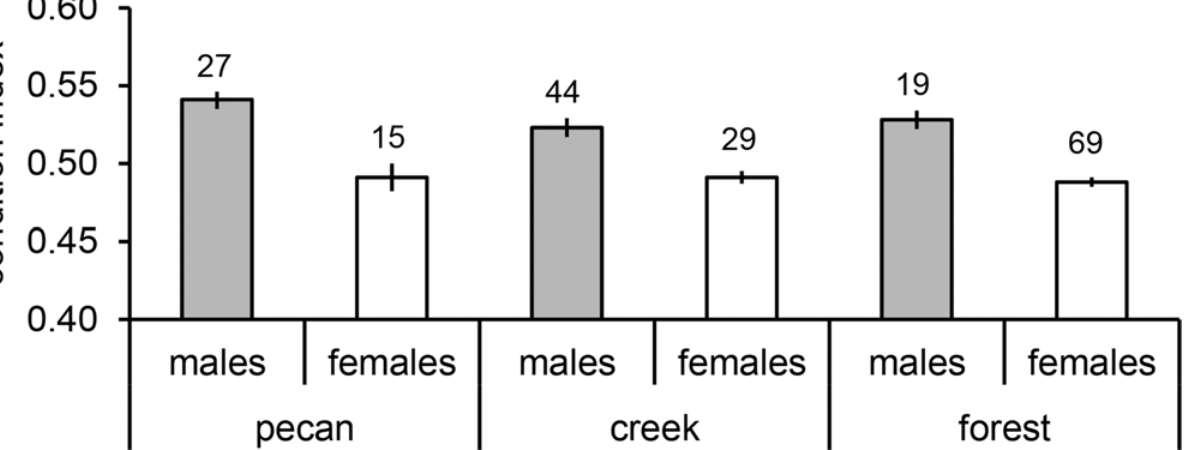
Fig 3. Body condition of males and females. Mean body condition ( ± SE) for males and females in pecan groves, forest fragments along creeks and forest are shown. Body condition represents the quotient of body mass to wing length. Numbers on top of bars indicate sample sizes. Gray bars: males; white bars: